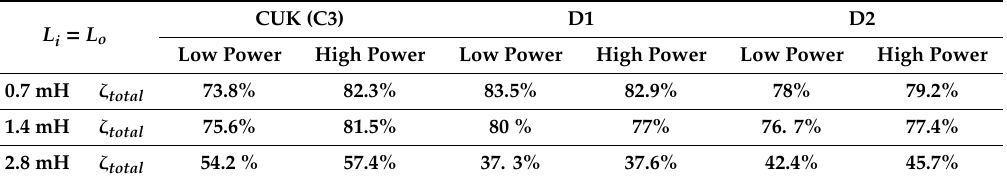
Table 4. Experimental converters’ overall e ffi